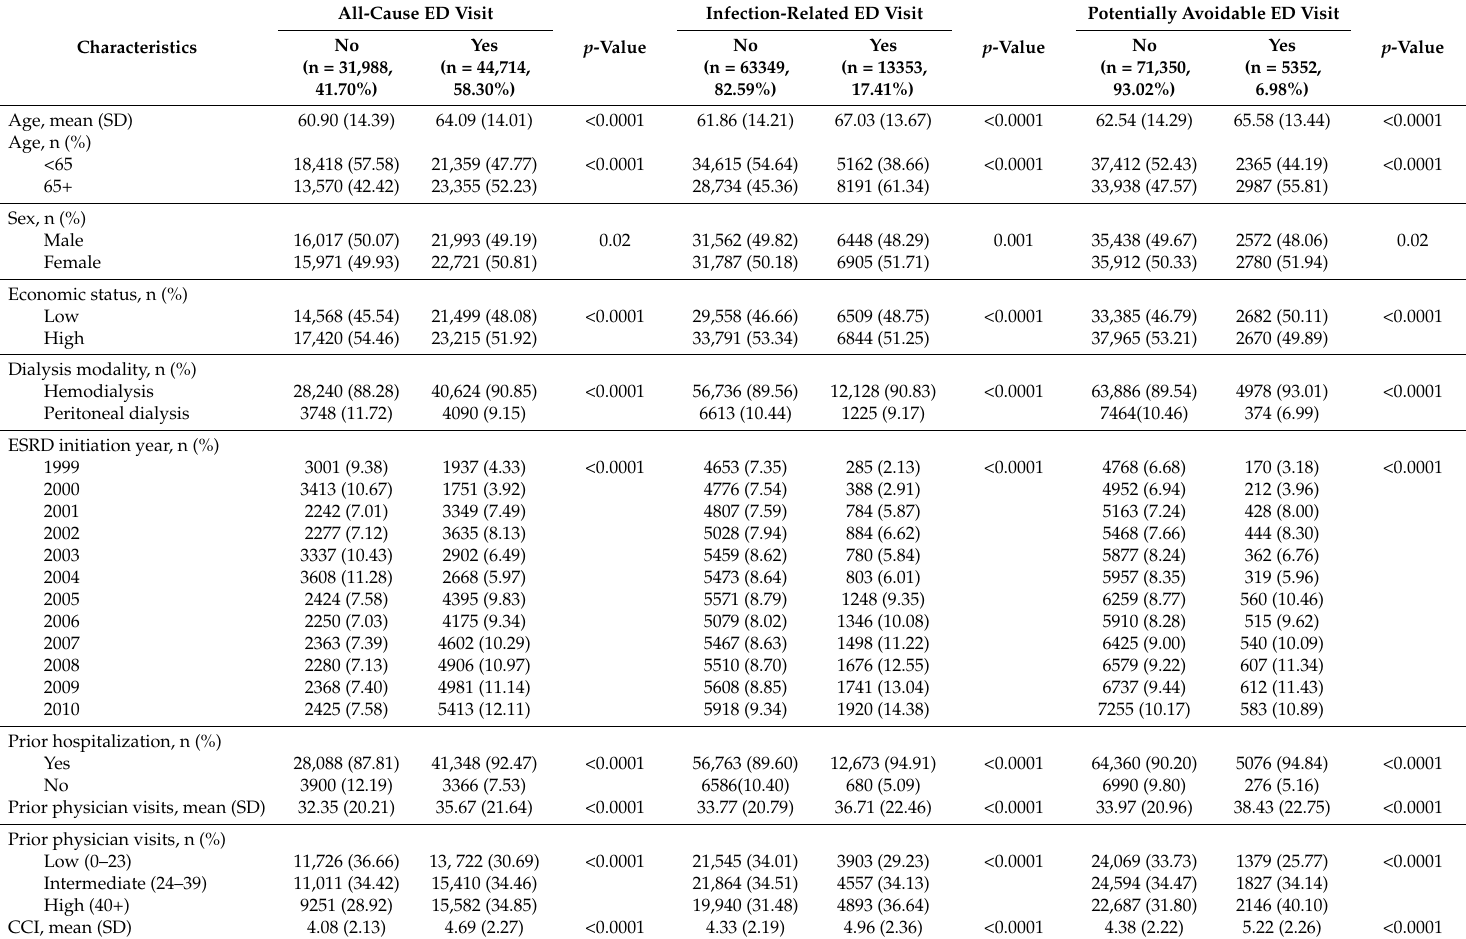
Table A1. Baseline characteristics of patients with and without ED